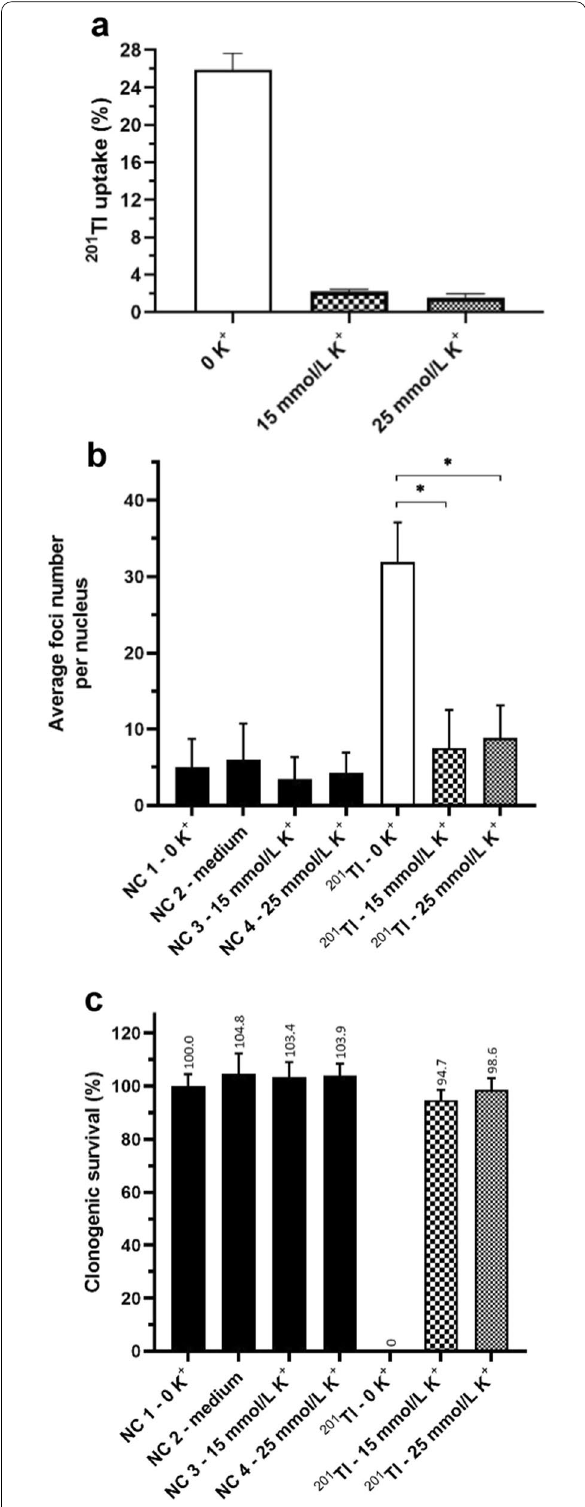
Fig. 5 201 Tl radiotoxicity—internal vs external 201 Tl. a 201 Tl uptake in DU145 cells in PBS with different concentrations of K + (0–25 mM) after 90 min incubation with 4000 kBq/mL of [ 201 Tl]TlCl. b Average number of foci per nucleus and c clonogenic survival measured in DU145 cells after 90 min incubation with 4000 kBq/mL of [ 201 Tl] TlCl and 15 or 25 mmol/L KCl and various non-radioactive controls (NC1-4). Data are presented as mean SD, n 3, triplicates, * ± = indicates P < 0.05